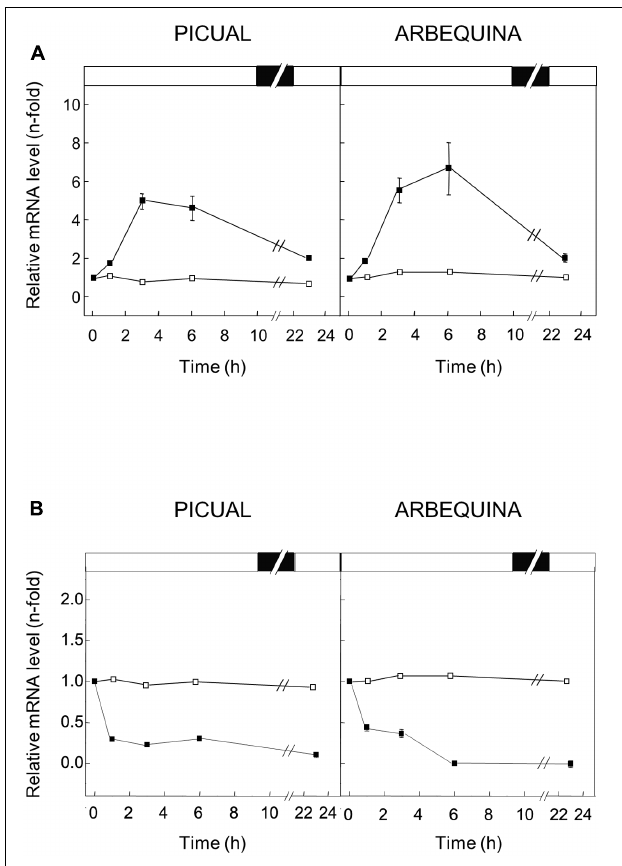
FIGURE 5 | Effect of low (A) and high (B) temperature on the relative expression levels of olive GLU gene in the Picual and Arbequina mesocarp tissues. Branches with approximately 100 olive fruit at turning stage (28 WAF) were incubated using standard conditions (open squares), or at a temperature of 15 ◦ C (A) or 35 ◦ C (B) (closed squares). Boxes in the upper part indicate light (open) or dark (closed) periods.